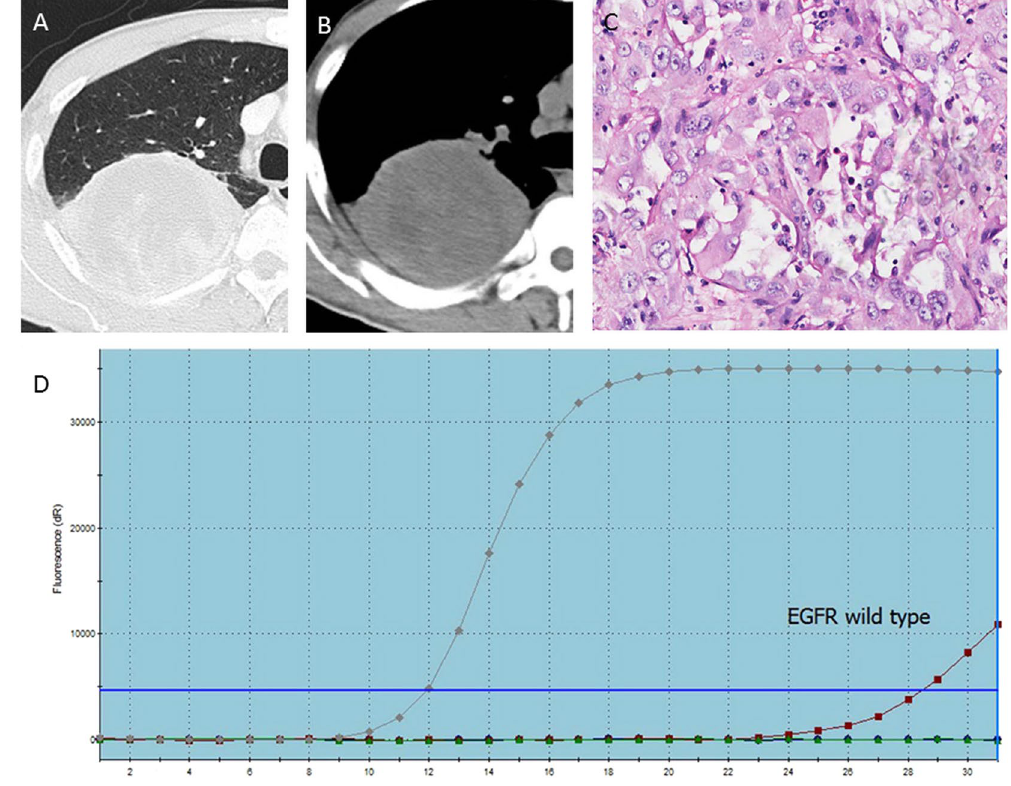
Figure 3. A 46-year-old man with a smoking history of 30 years had right upper lobe lung adenocarcinoma in EGFR wild type, in whom axial CT images ( A,B ) show a solid lump about 90 mm with a litte fibrosis and no pleural retraction or Spicule sign. The PCR picture ( C ) and pathological photo ( D ) show that the red line has no association with the upper line, indicating the EGFR wild